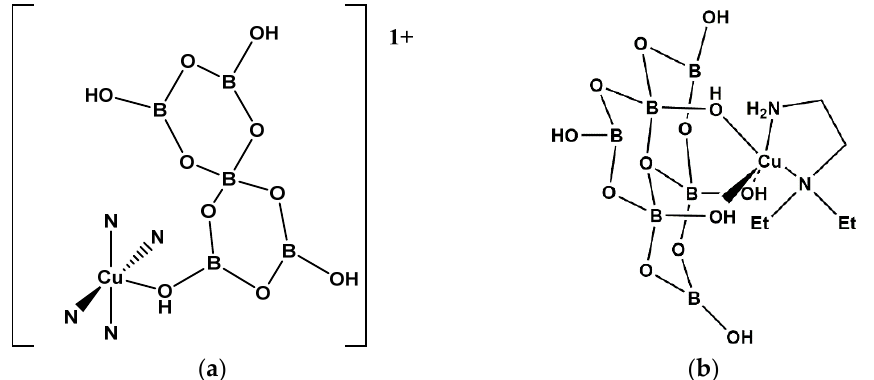
Figure 5. ( a ) The cation present in [Cu(pn) 2 {B 5 O 6 (OH) 4 }][B 5 O 6 (OH) 4 ] · 4H 2 O ( 14 ), and ( b ) the un- charged building unit of [Cu(deen){B 6 O 7 (OH) 6 }]·5H 2 O ( 19